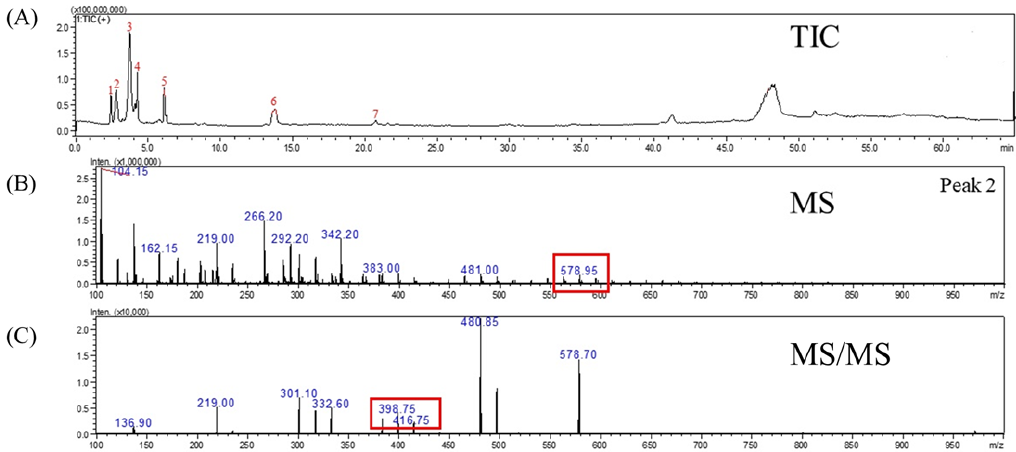
Figure 4. The mass spectrometry of ( A ) total ion chromatogram (TIC), ( B ) MS spectra, and ( C ) MS/MS